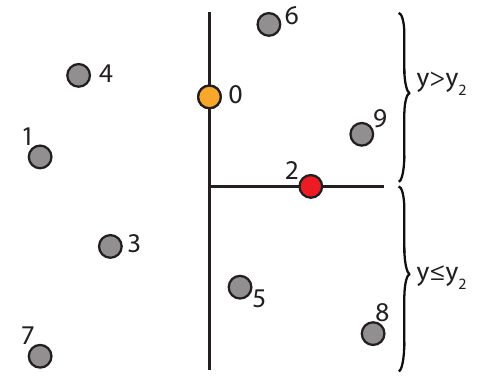
Figure 5. Recursively build the k-d tree in the right